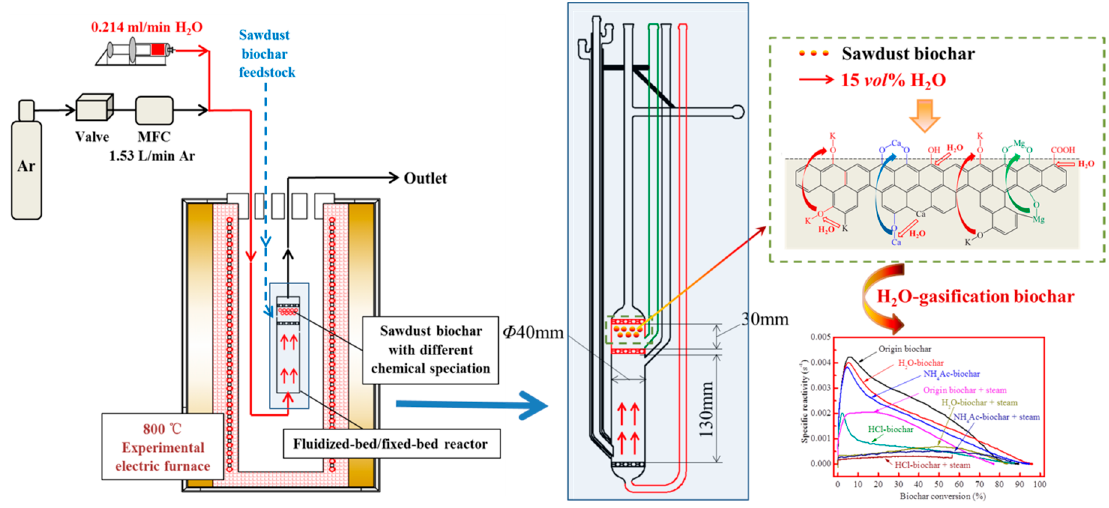
Figure 3. A schematic diagram of the steam gasification experimental process.